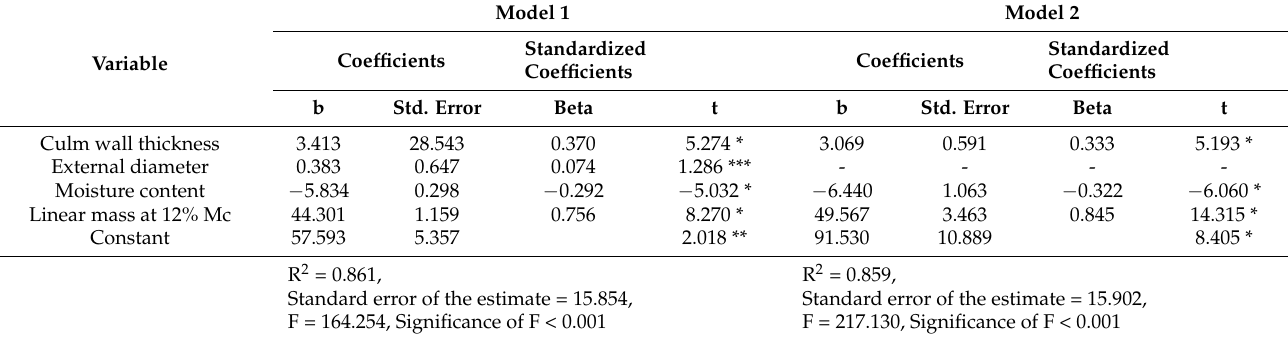
Table 4. Multiple linear regression analysis for the dependent variable maximum compressive load ( F u ).